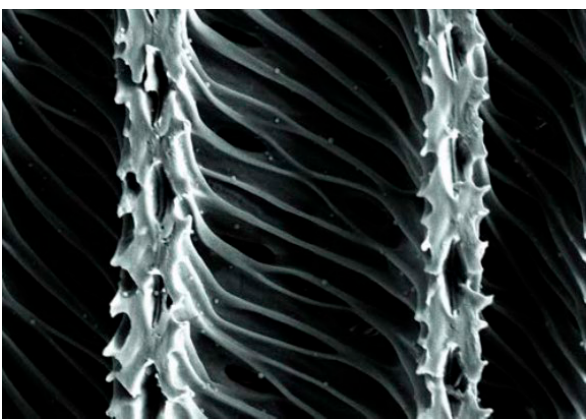
Figure 6. The clematis ( Clematis vitalba ) is a woody plant which is not self-supporting, belonging to the group of lianas, which have the highest-known speeds of transport of the raw sap. A maxi- mum of 222 metres per hour was measured by Kucera and Bossard (1981). The strongly helical structure of the vessel walls probably plays here an essential role (Photo T.